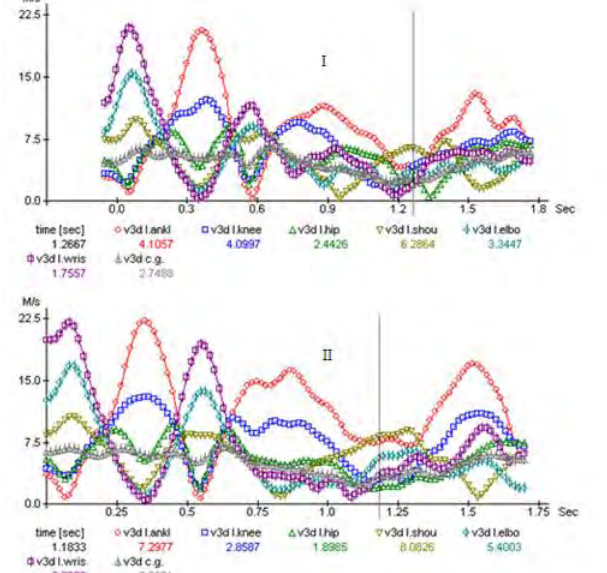
Fig.6. Resultant speed values of ankle, knee, hip, shoulder, elbow and wrist joints, GMC in phase of main movements; MP – passing in second somersault during grouped back double somersault after rondat (tested A, upper section of figure, variant 1, time 1. 266sec.с ) and arched back double somersault after rondat- back turnover (tested B, variant 2, lower section of figure, time 1. 183sec.).